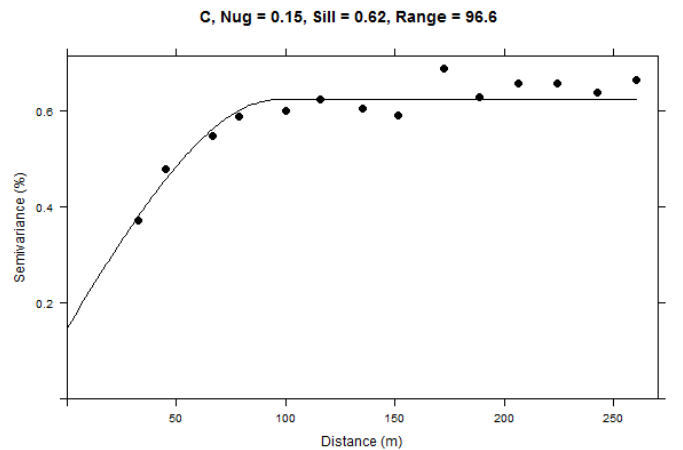
Figure 4. Experimental semivariogram for soil carbon (C) content in the studied vineyard. The theoretical model fitted to this semivariogram is shown along with the values of its parameters (Nug = Nugget effect).